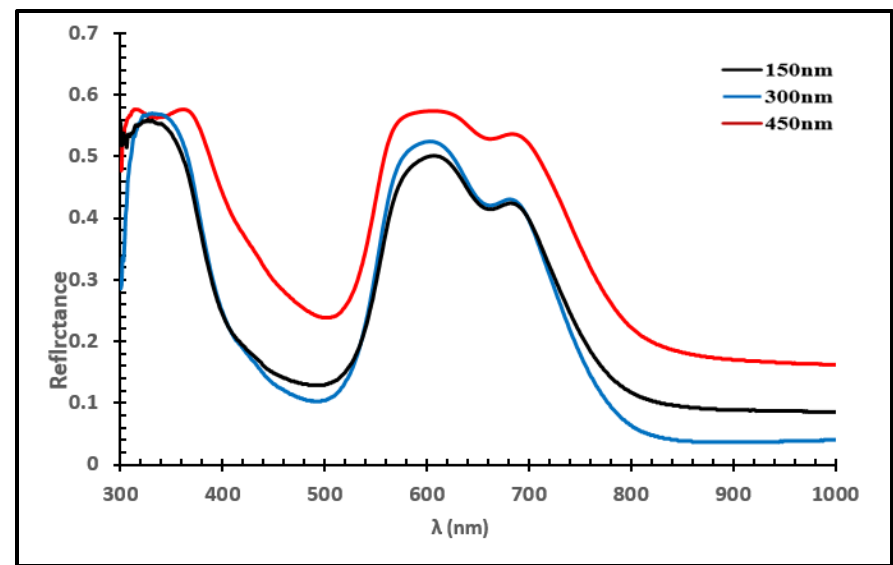
Fig.4: Reflectance spectra for thin films of CuPc prepared via PLD technique at different thickness.